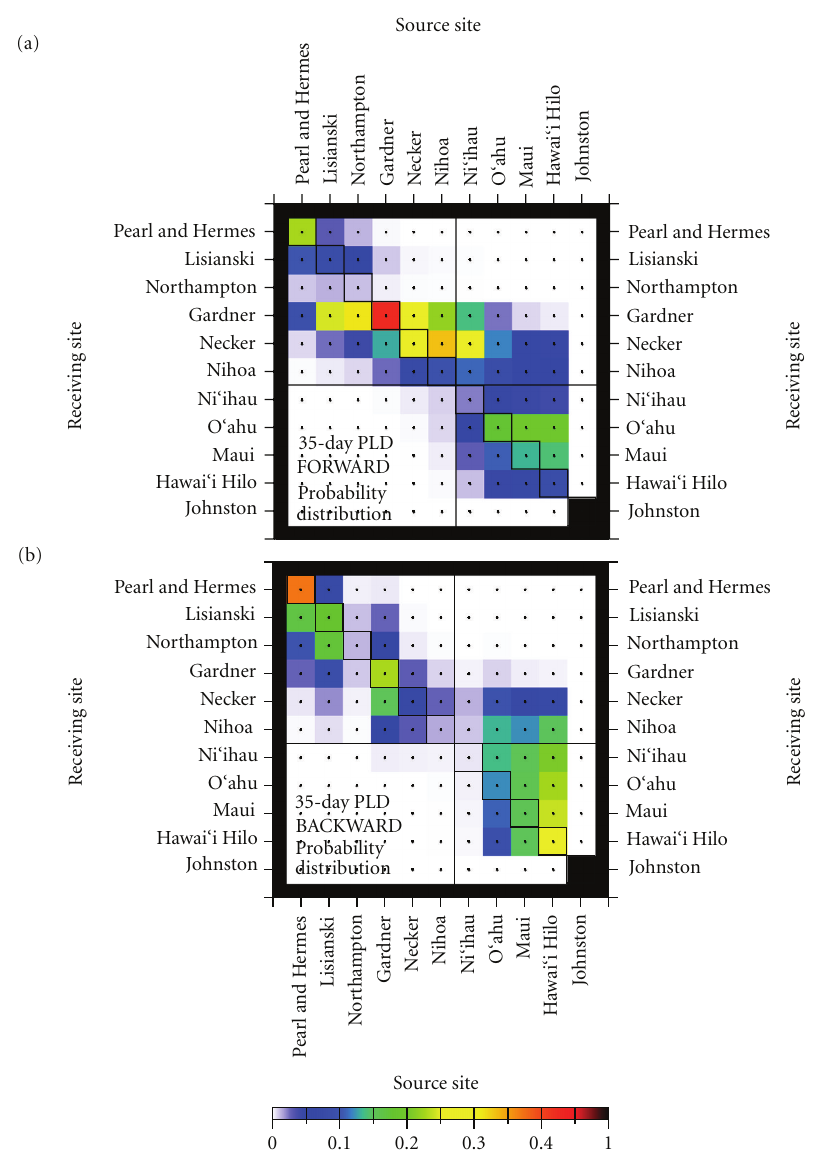
Figure 3: (a) Forward and (b) backward projections of multigenerational settlement probabilities for a 35-day PLD. Values are an average of five runs of the 1,000-generation model. For example, (a) about 30% of successfully settled propagules released from Northampton settled at Gardner and (b) about 2% of successfully settled propagules at Gardner originated at Northampton. The horizontal and vertical lines separate Main Hawaiian Islands and Northwestern Hawaiian Islands, and the diagonal shows